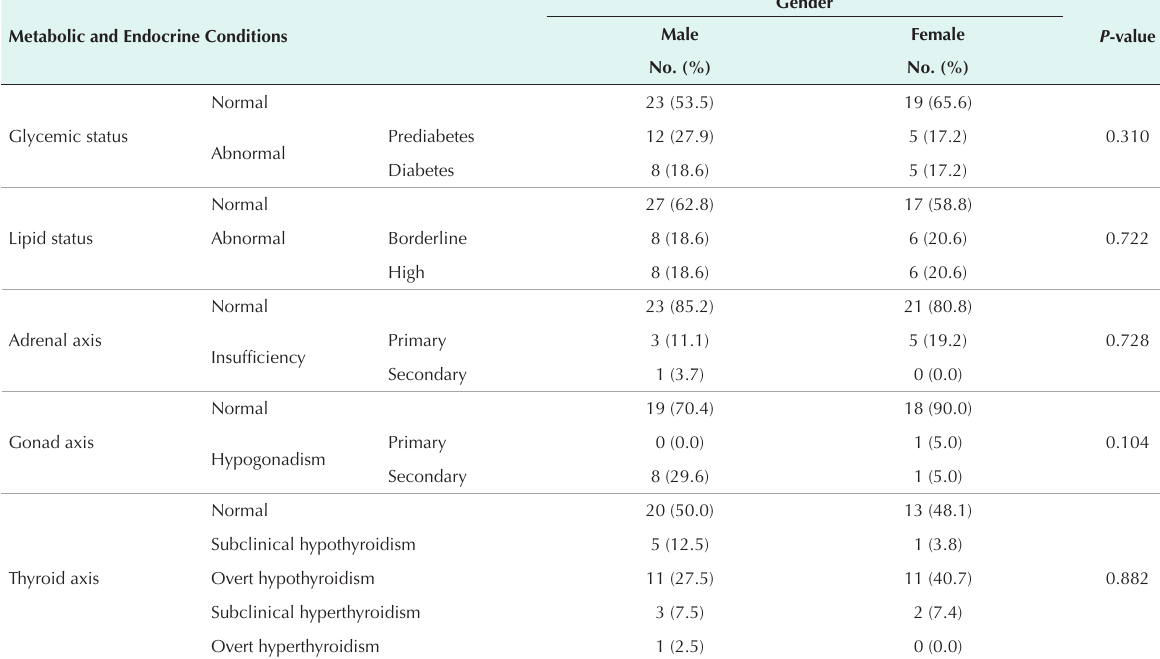
Table 4. Metabolic and Endocrine Disorders by Gender in HIV-positive Patients